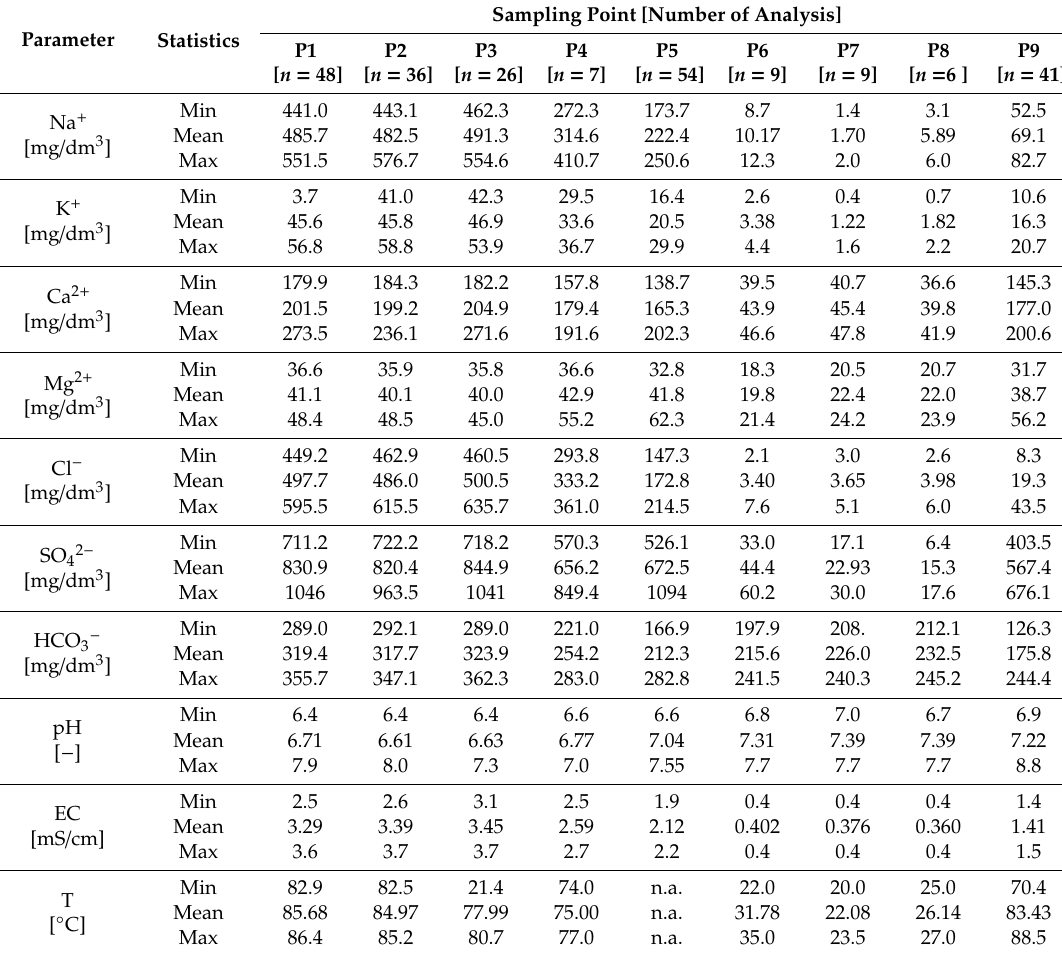
Table 2. Basic physicochemical parameter of thermal water in Podhale Trough (archival data 2010–2019). Parameter